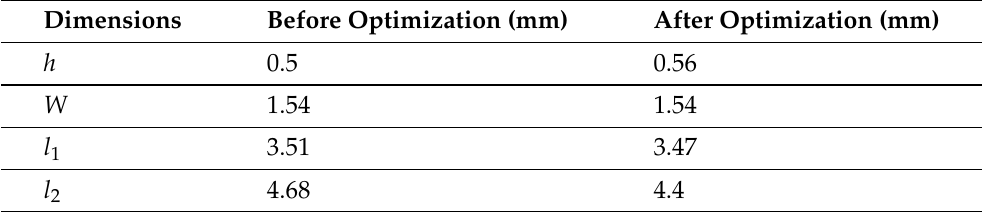
Table 2. Unit cell dimensions before and after software